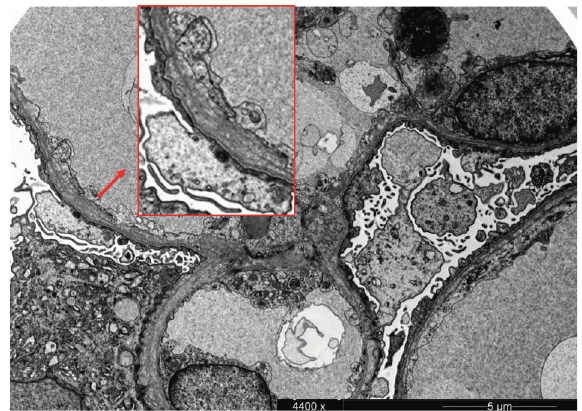
Figure 2: Electron micrography of the patient’s kidney biopsy. It visualizes irregular thickness of glomerular basement membranes with splitting of the lamina densa (inset red box, 2-fold magnifi- cation) and severe podocyte foot process effacement. Bar: 5 μ m.